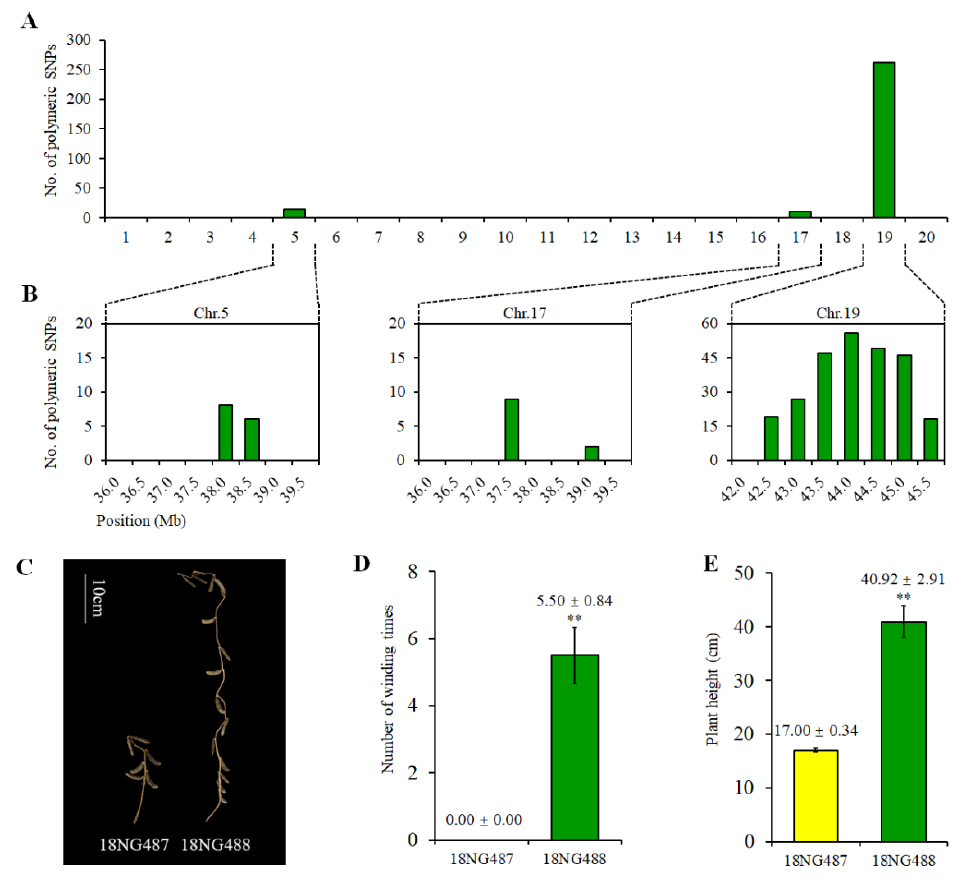
Figure 5. Genotype and phenotype evaluations of the NILs with erectness (18NG487) and vining growth (18NG488). ( A ) The number of polymorphic SNPs on all chromosomes between the two NILs. ( B ) The number of polymorphic SNPs on chromosomes 5, 17 and 19 of the two NILs; each bar represents the number of polymorphic SNPs between the NILs in a 5 Kb region. Phenotypic illus- tration ( C ), VG ( D ) and PH ( E ) of 18NG487 and 18NG488. Data are mean ± s.d., n = 15; ** p < 0.01 (Student’s t -test).